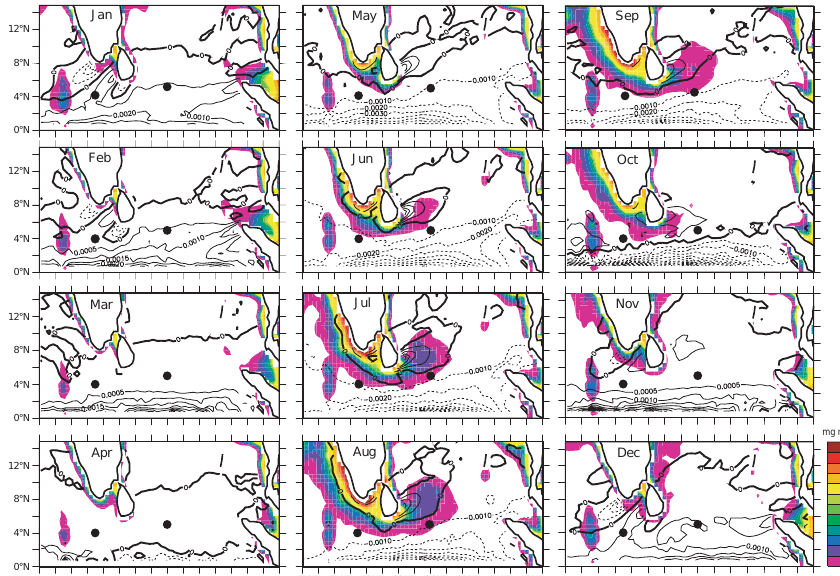
Fig. 9. Spatial distribution of monthly mean climatology (1997–2010) of the chlorophyll ≥ 0.3mgm − 3 (shading) overlaid with Ekman- pumping velocity (contour lines) for January to December. Solid (dashed) lines are for positive (negative) values and thick solid line is for zero Ekman-pumping velocity. Filled circles denote the location of SBBT and EIOT.